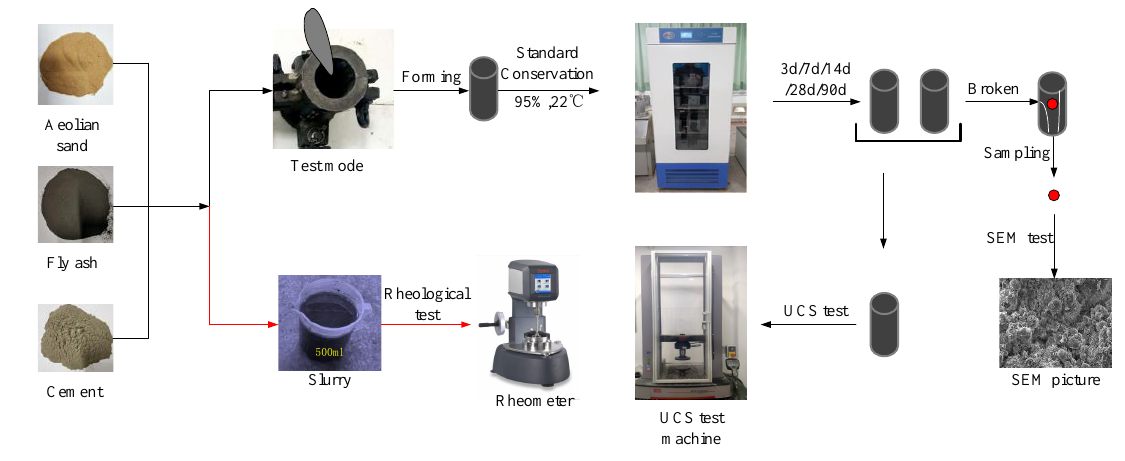
Figure 4. Experimental flowchart.